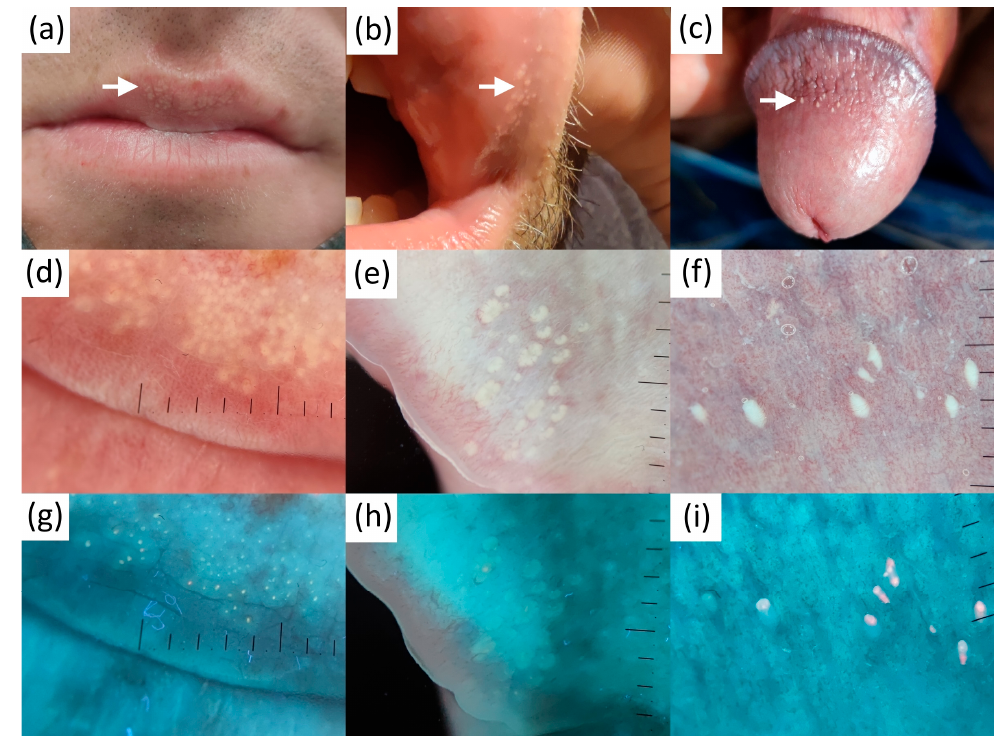
Figure 2. Clinical ( a – c ), contact polarized ( d – f ) and ultraviolet-induced fluorescence ( g – i ) dermato- scopic images of 3 representative patients with Fordyce spots. Non-polarizing-specific white structures of LP turned into poorly demarcated UVFD- dark lines, whereas polarizing-specific white lines were not visible in UVFD (Figure 3). Erythematous areas seen at the periphery of the LP lesions in polarized dermatoscopy proved to be seemingly larger and darker in